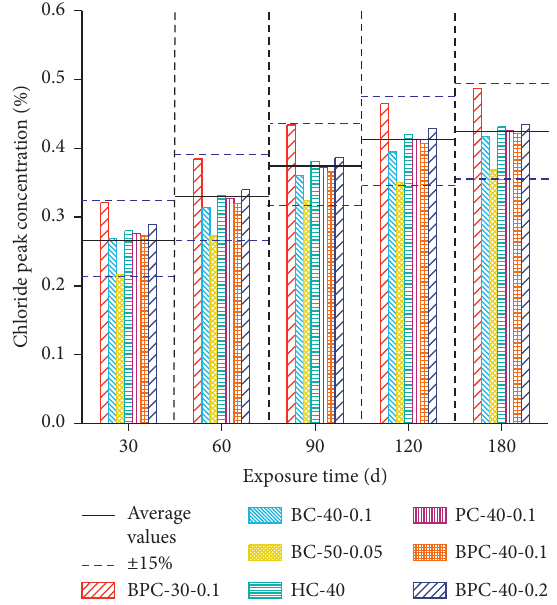
Figure 8: Chloride peak concentration of BPFRC at different exposure